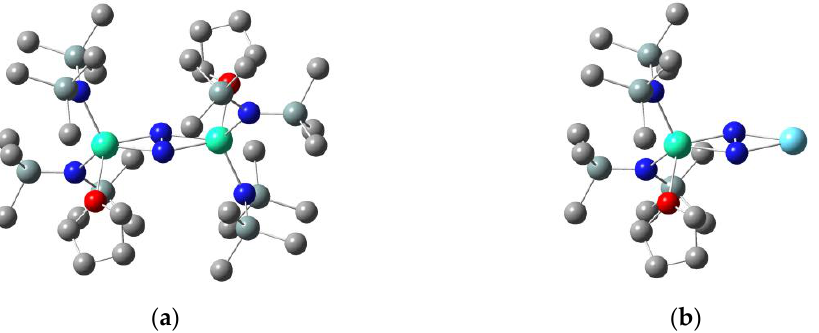
Figure 12. ( a ) Crystal structures of {[(Me 3 Si) 2 N] 2 (THF)Ln} 2 ( μ - η 2 : η 2 -N 2 ) − (Ln = Gd, Tb, Dy, Ho, Er). ( b ) Model structure of